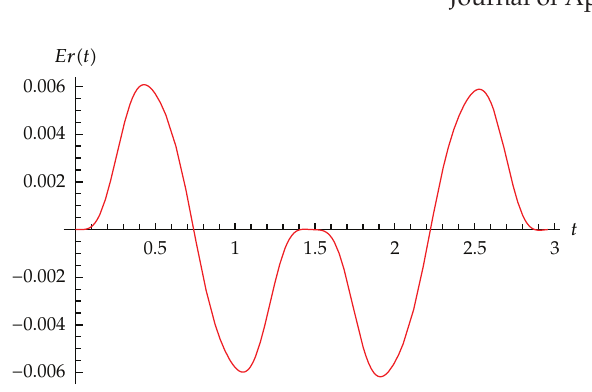
Figure 6: The error between the numerical and approximate analytical solution (cid:2) 2.34 (cid:3) in case b: a (cid:9) b (cid:9) 1 , A (cid:9)